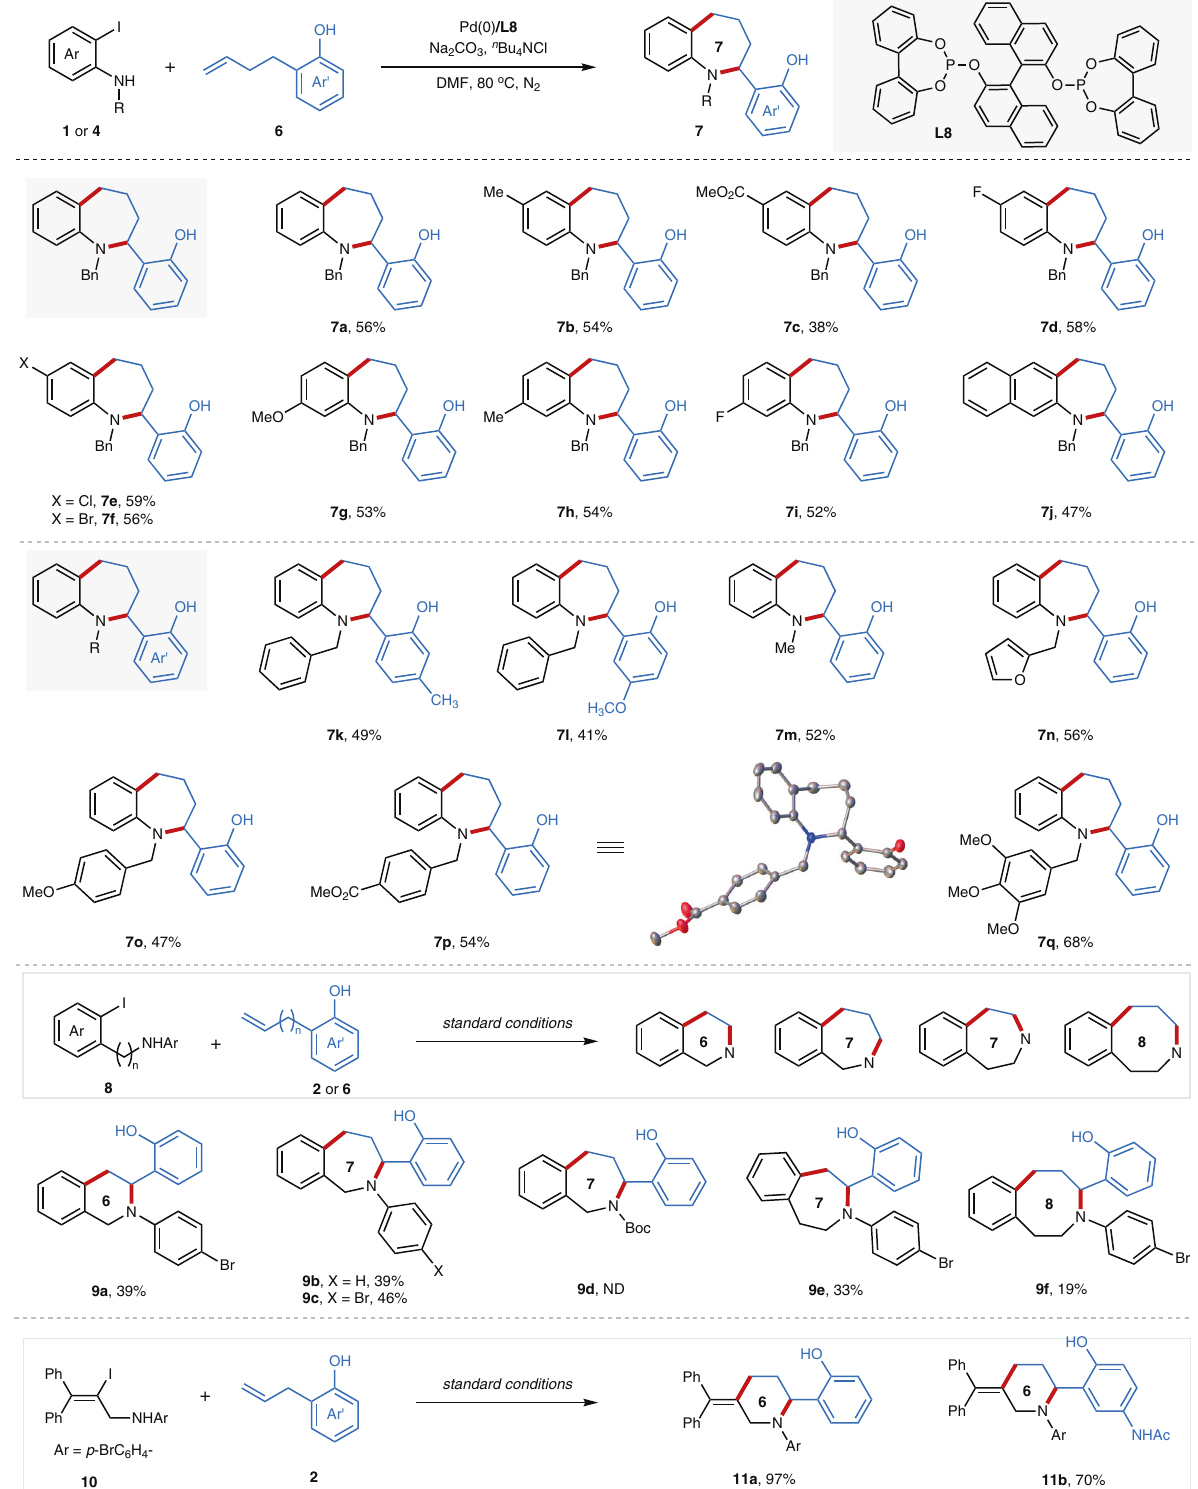
Fig. 5 | The synthesis of other 6-, 7-, 8-membered azaheterocycles via Pd- catalyzed migratory cycloannulation. The values under each structure indicate isolatedyields(SeeSupplementaryInformationforexperimentaldetails).Reaction conditions: 1 or 4 (0.4mmol, 4.0 equiv.), 2 or 6 (0.2mmol), Pd 2 (dba) 3 (2.8mg, 1.5mol%), L8 (4.3mg, 3.0mol%), Na 2 CO 3 (53.0mg, 2.5 equiv.), n Bu 4 NCl (111.2mg,